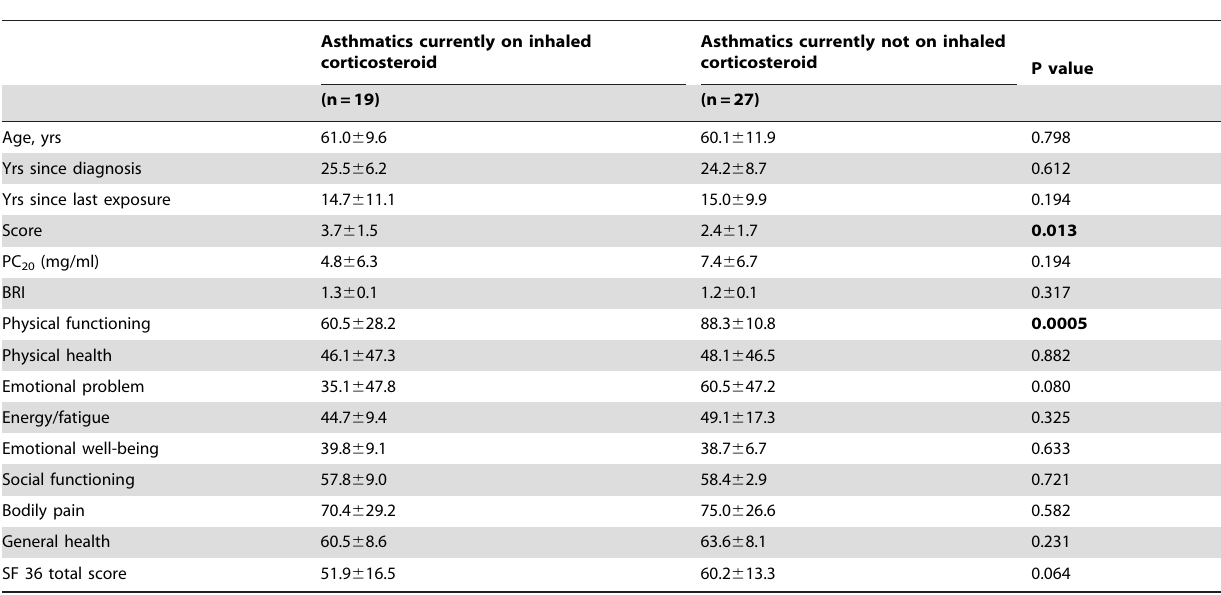
Table 5. Association of inhaled corticosteroid usage with clinical parameters, airway responsiveness indices and HRQL scores.